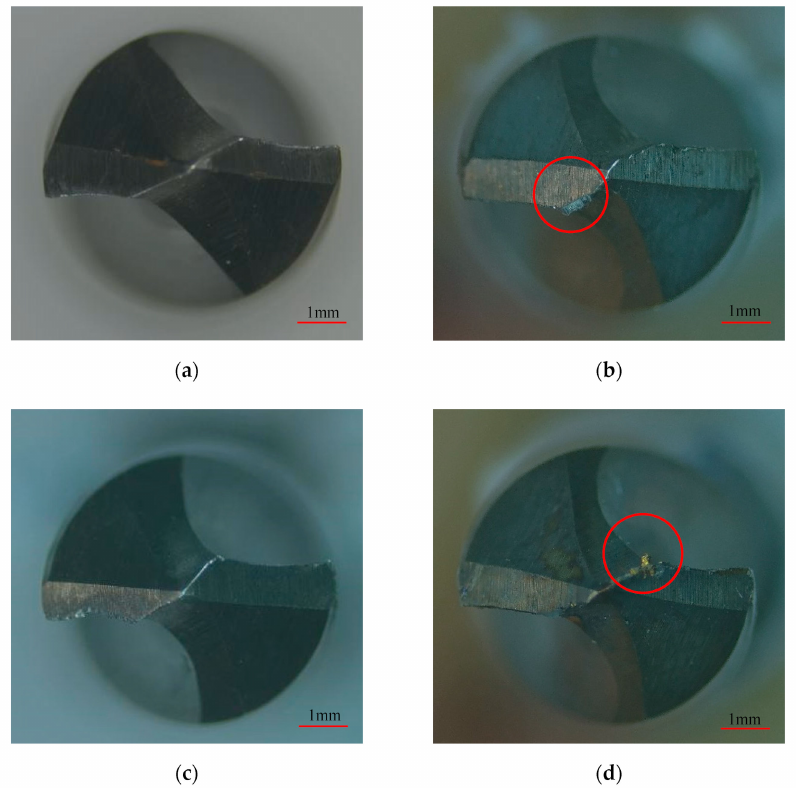
Figure 8. Bit failure wear morphology. ( a ) Uncoated bit at drilling speed of 15 m/min. ( b ) Coated bit at drilling speed of 15 m/min. ( c ) Uncoated bit at drilling speed of 20 m/min. ( d ) Coated bit at drilling speed of 20 m/min.